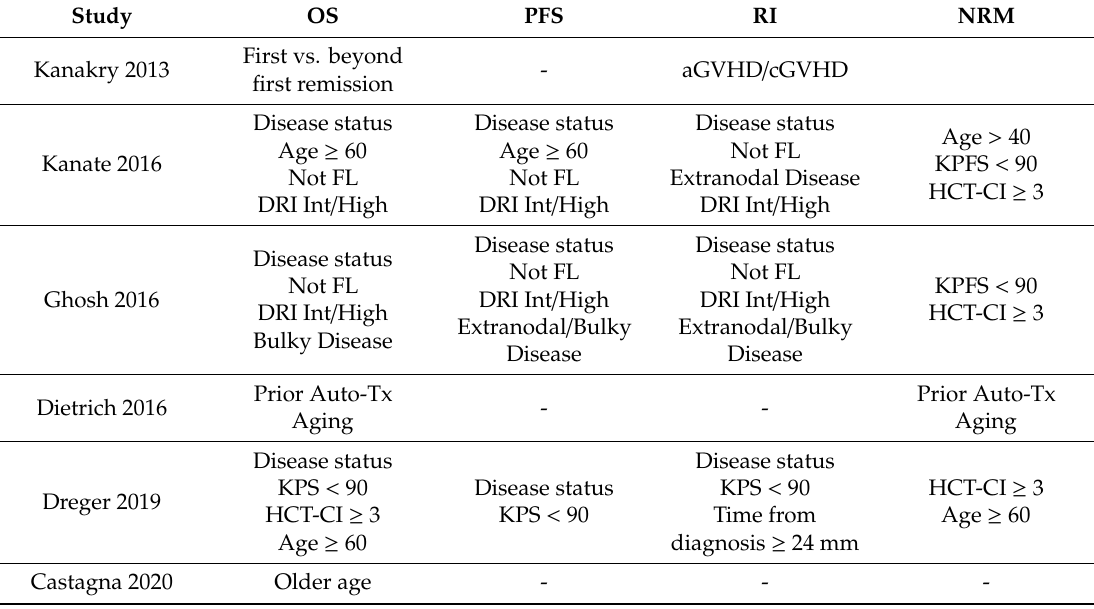
Table legend: OS: overall survival; PFS: progression free survival; NRM: non-relapse mortality; RI: relapse incidence; HCT-CI: hematopoietic cell transplant-comorbidity index; KPS: karnofsky performance status; FL: follicular lymphoma; DRI: disease risk index; aGVHD / cGVHD: acute and chronic